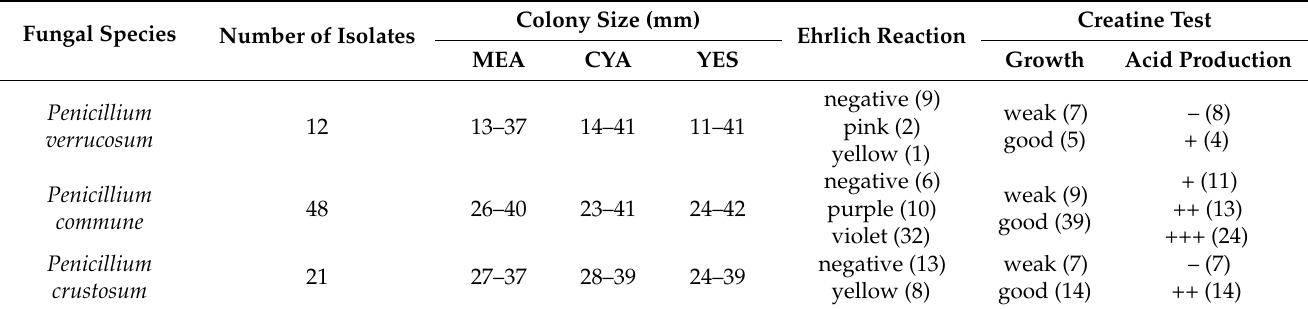
Table 2. Phenotypic features and morphological identification of three Penicillium species isolated from chicken eggs.